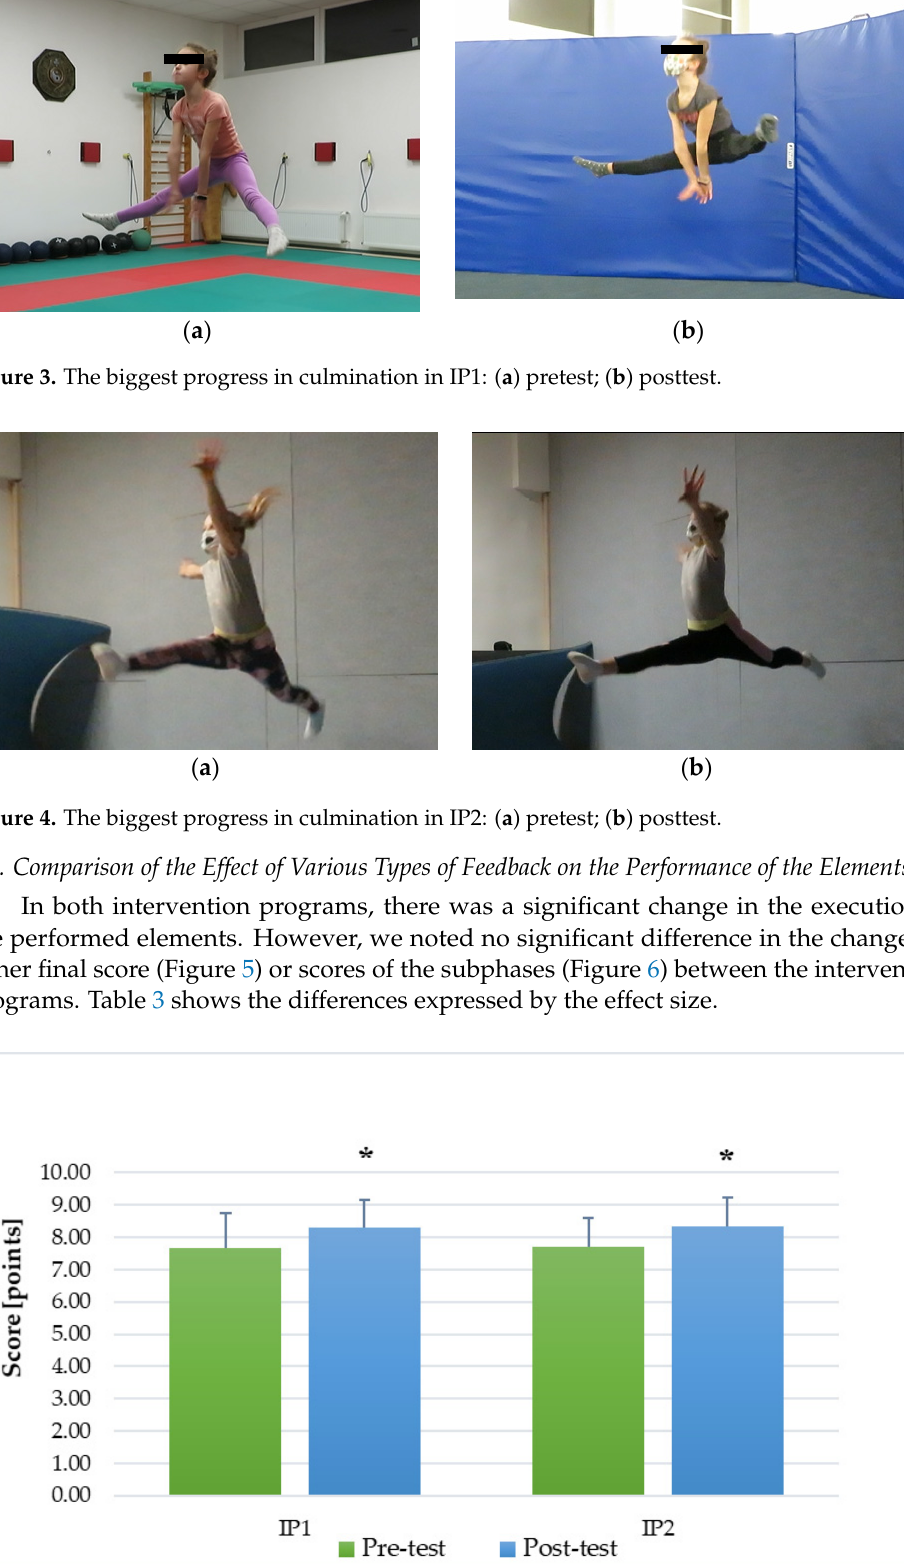
Table 2. Changes in the performance of the elements in IP1 and IP2.